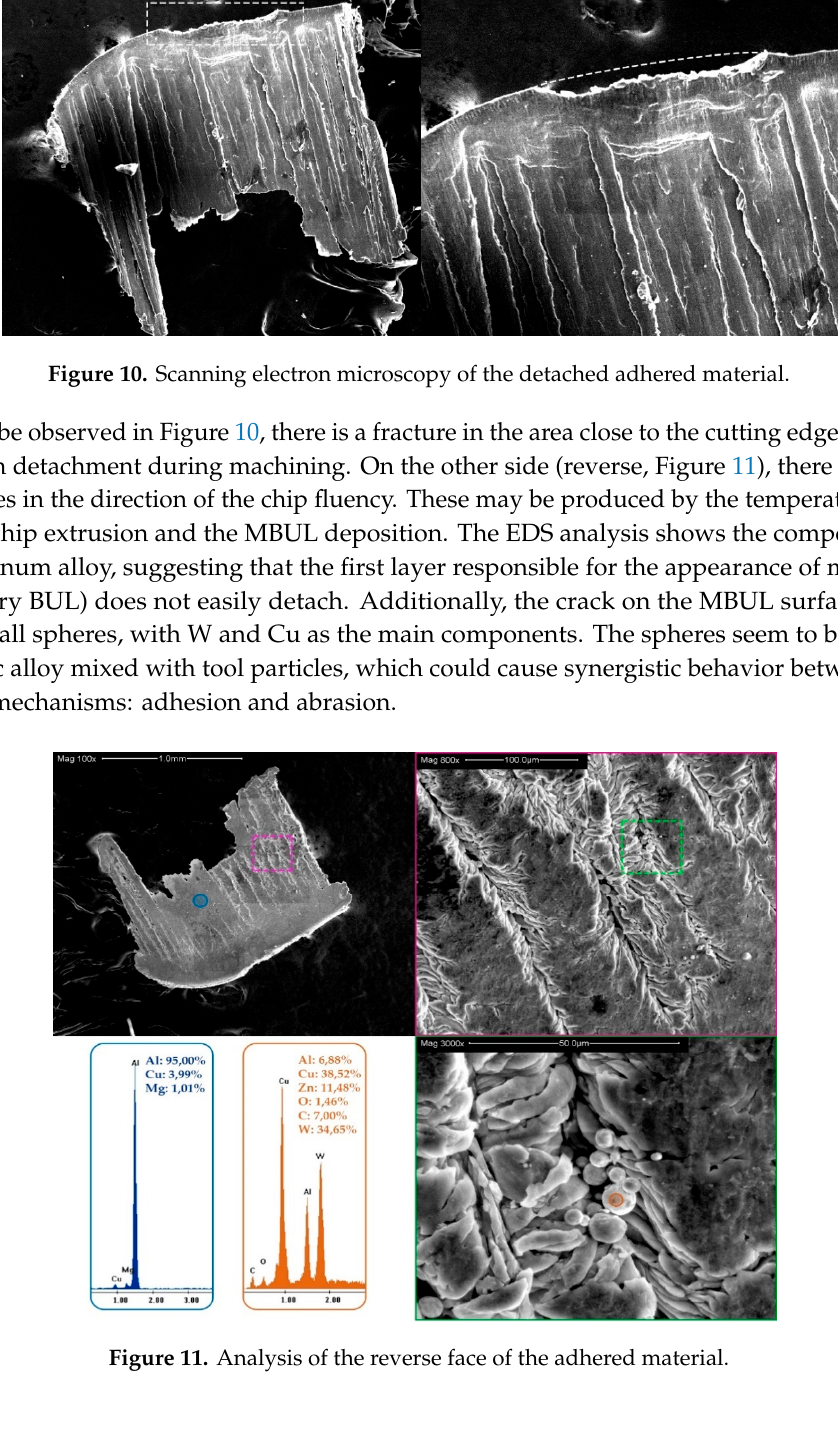
Figure 9. ( a ) Cross-section of the tool. ( b ) Overlapped layers of adhered material. ( c ) SEM of stratified structure of adhered material.